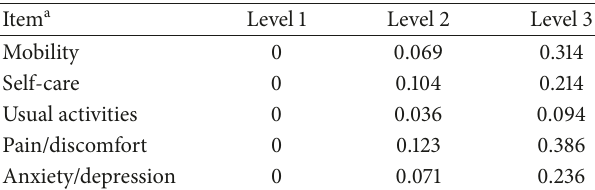
Table 1: Computation of EQ-5D index